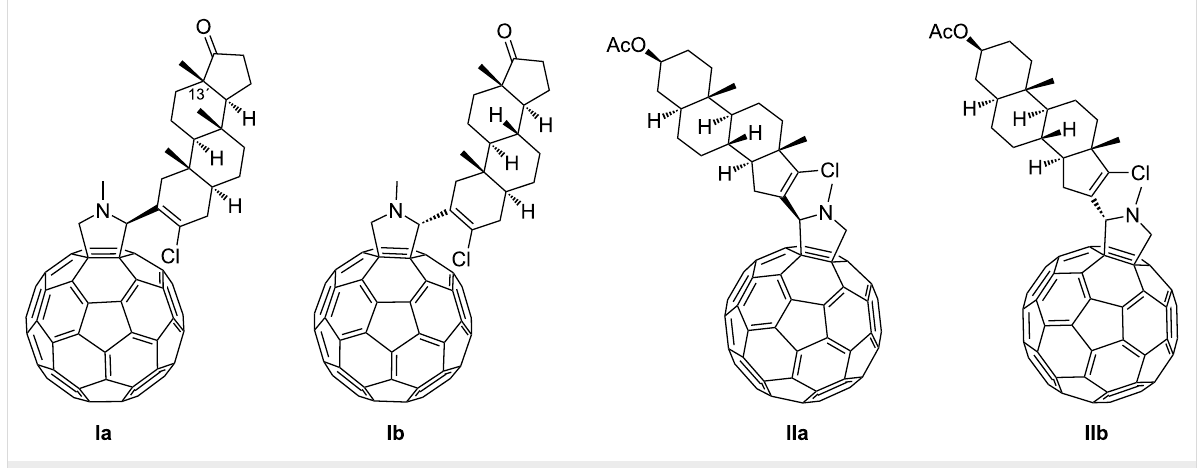
Figure 1: Chemical structure of the different C 60 –androsterone